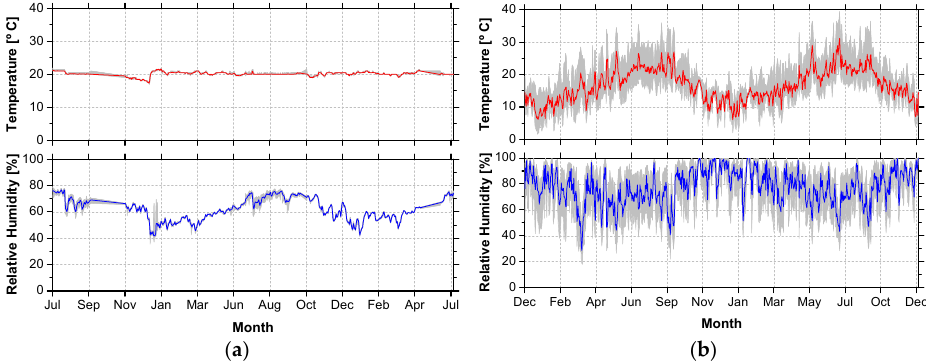
Figure 2. Temperature and relative humidity recorded in environments ( a ) E1 and ( b ) E6.